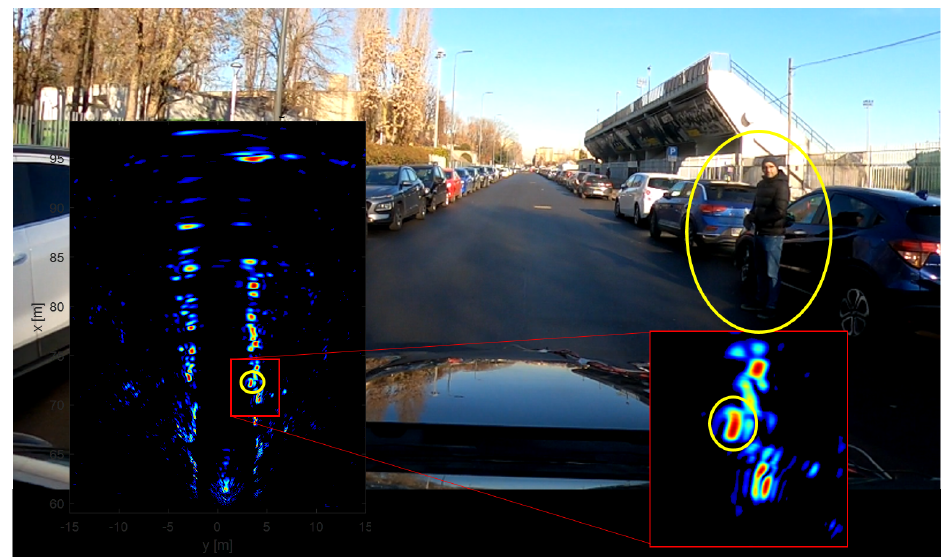
Figure 13. Detection of standing pedestrians from SAR images in an open road (froward-looking configuration): (background) camera image of the scene; ( left ) SAR image of the whole imaged area. ( right ) Zoomed SAR image highlighting the pedestrian standing still next to parked